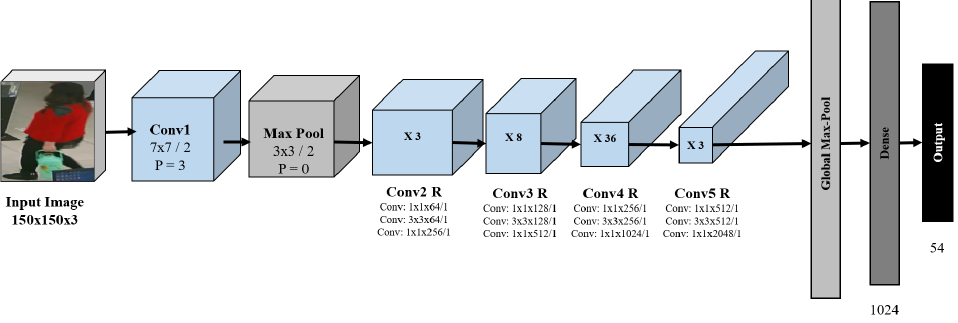
Figure 5. Overview of the ResNet 152 v2